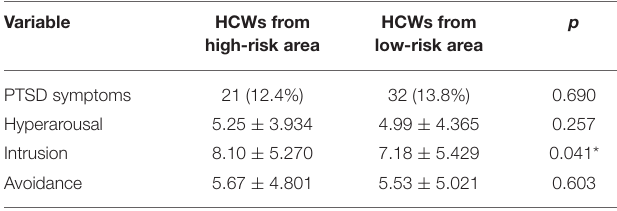
TABLE 2 | Comparisons of the IES-R scores obtained by HCWs from high-risk area and HCWs from low-risk area. Variable